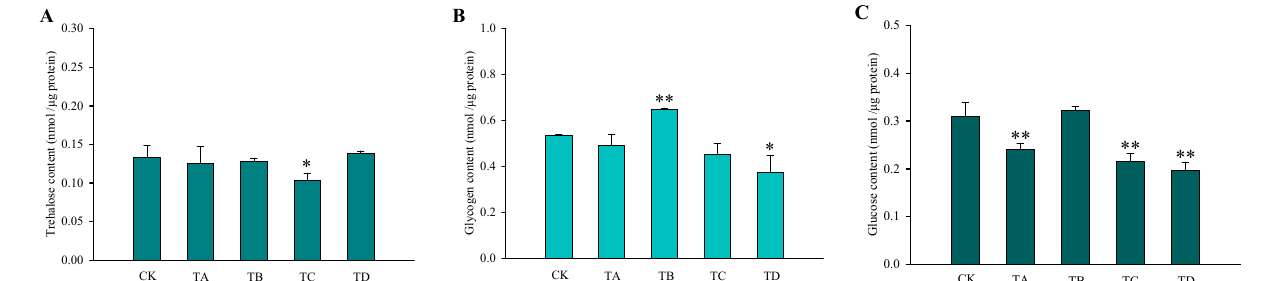
Figure 3. Changes in the three carbohydrates in T. castaneum treated with different CO 2 concentrations, represented by CK, TA, TB, TC, and TD. ( A ) trehalose content; ( B ) glycogen content; ( C ) glucose content. CK, treated with air for 48 h; TA, treated with 25% CO 2 + 75% air for 48 h; TB, treated with 50% CO 2 + 50% air for 48 h; TC, treated with 75% CO 2 + 25% air for 48 h; TD, treated with 95% CO 2 + 5% air for 48 h. * p < 0.05, ** p < 0.01, according to Student’s t ‐ test.